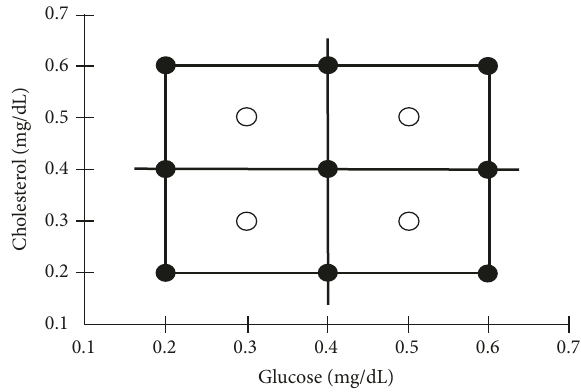
Figure 1: Factorial design. ( e ) Experiments of design. ( I ) Internal validation